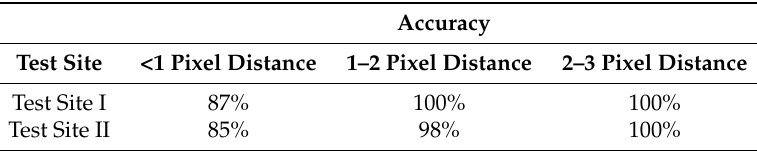
Table 5. Algorithm performance for different neighborhood sizes.